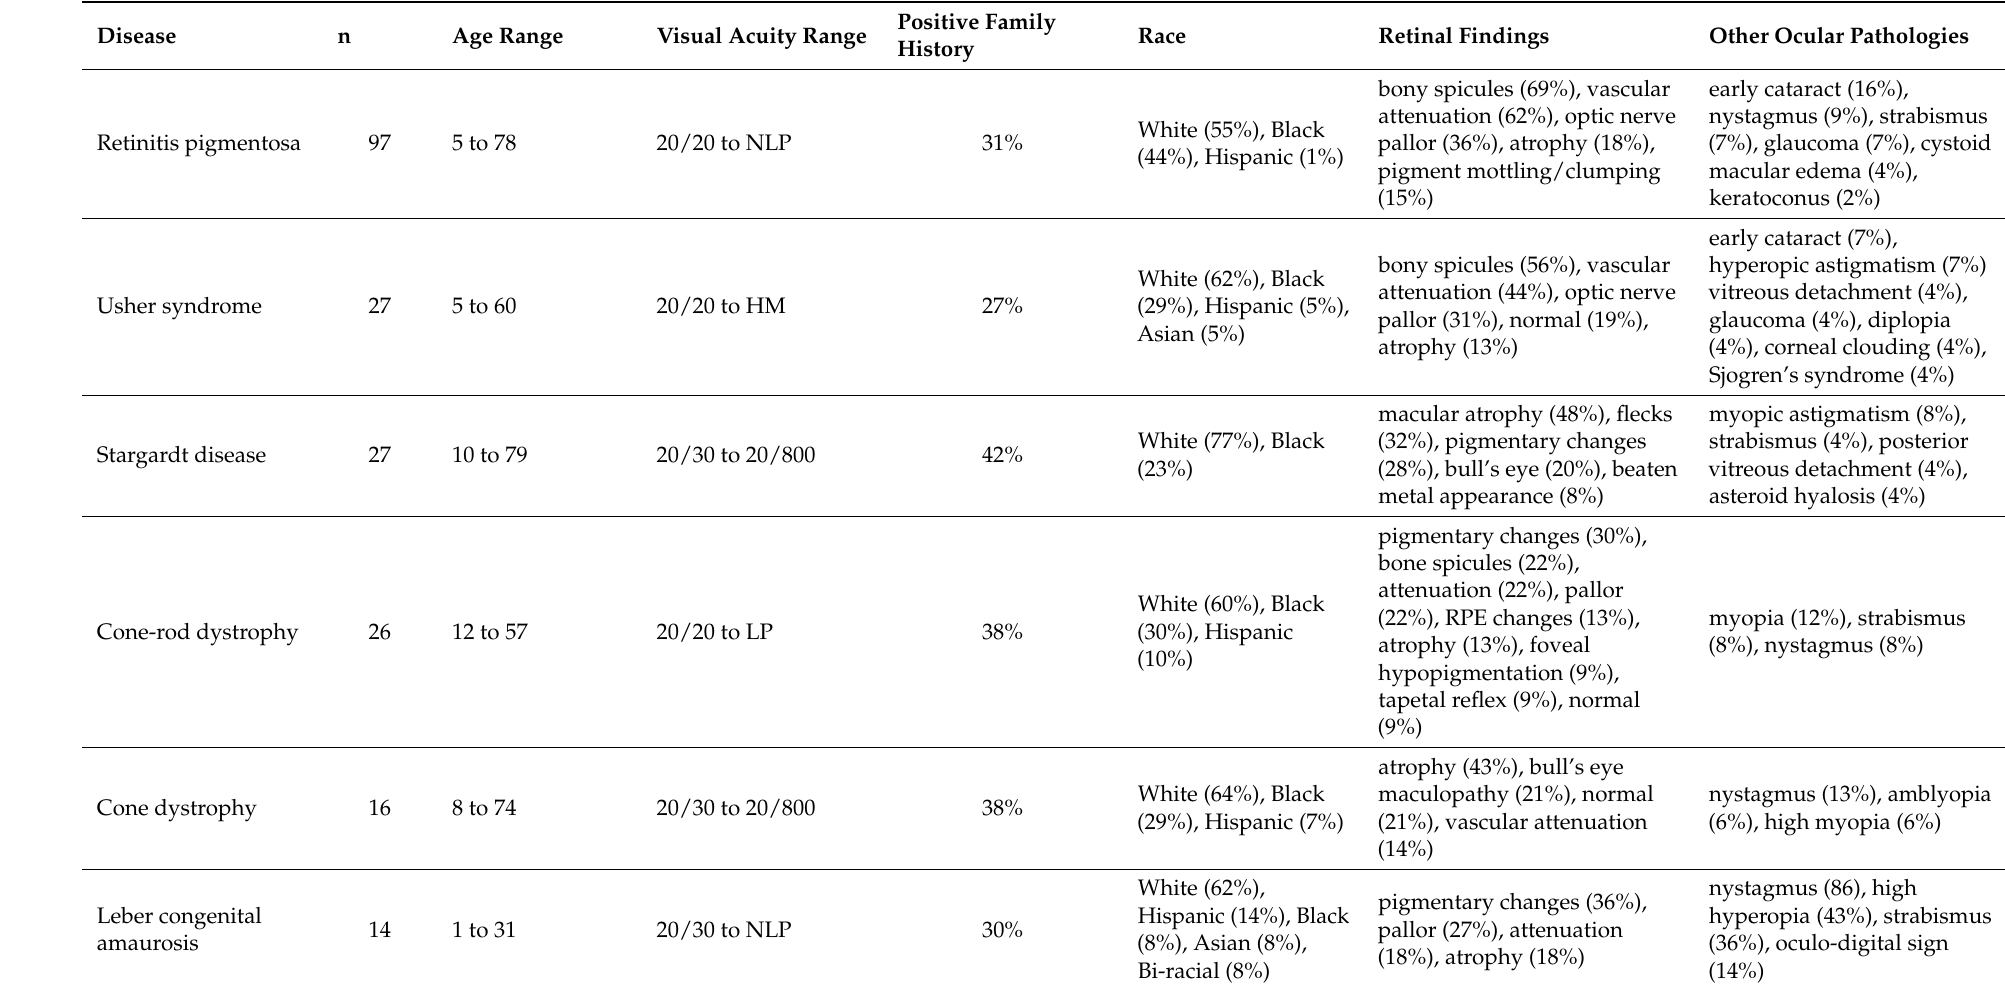
Table 2. Individual disease